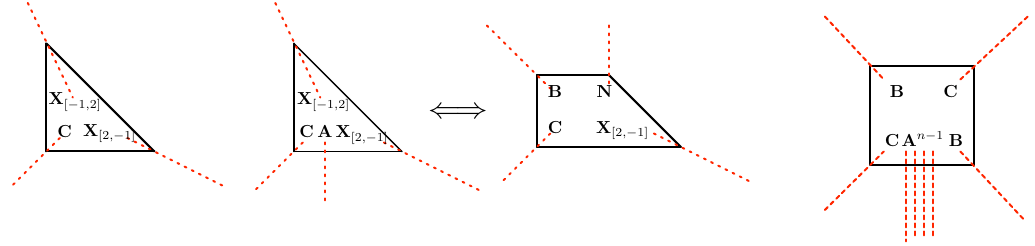
Figure 3 . 7-brane configurations for 5d rank-1 theories. The first web is the E 0 theory of b E 0 7-brane configuration. The second and the third ones are equivalent and describe the SU(2) of be E . The last one is generic 7-brane configuration of SU(2) + ( n − 1) F of b E 1 global